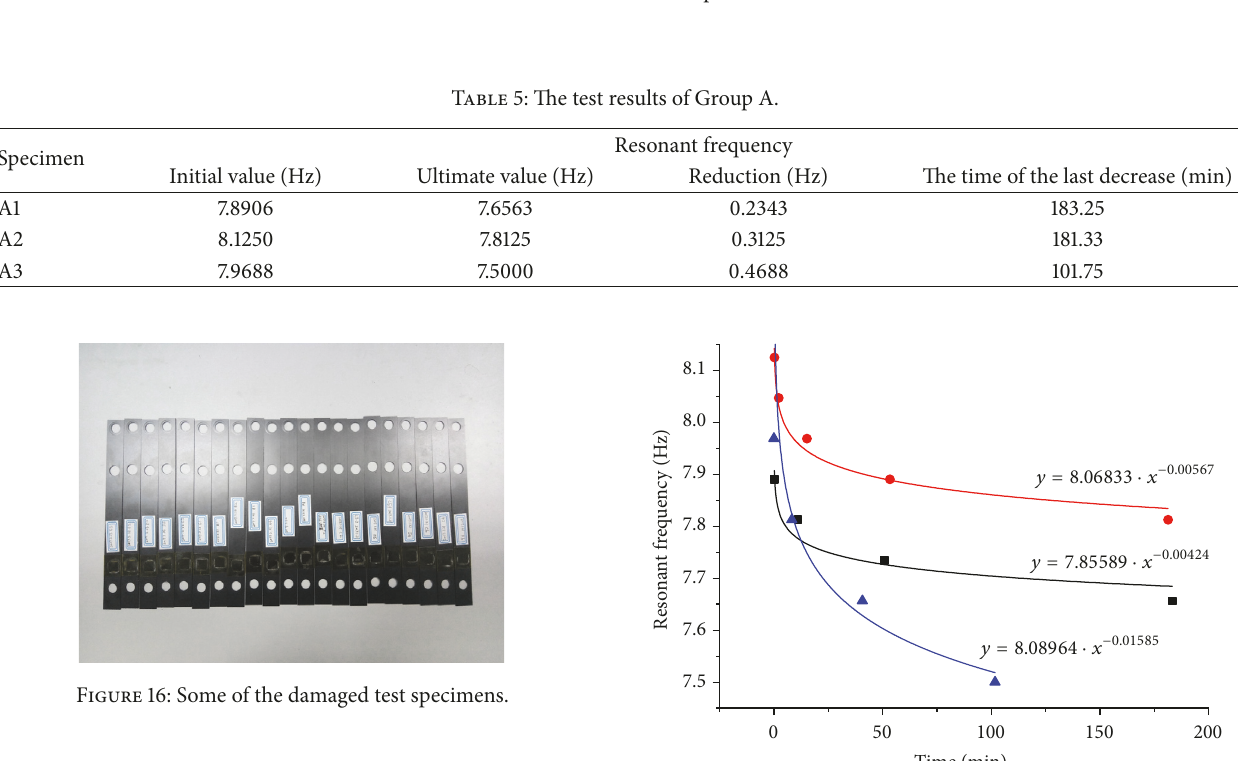
Figure 15: The FEA result of Specimen 1.